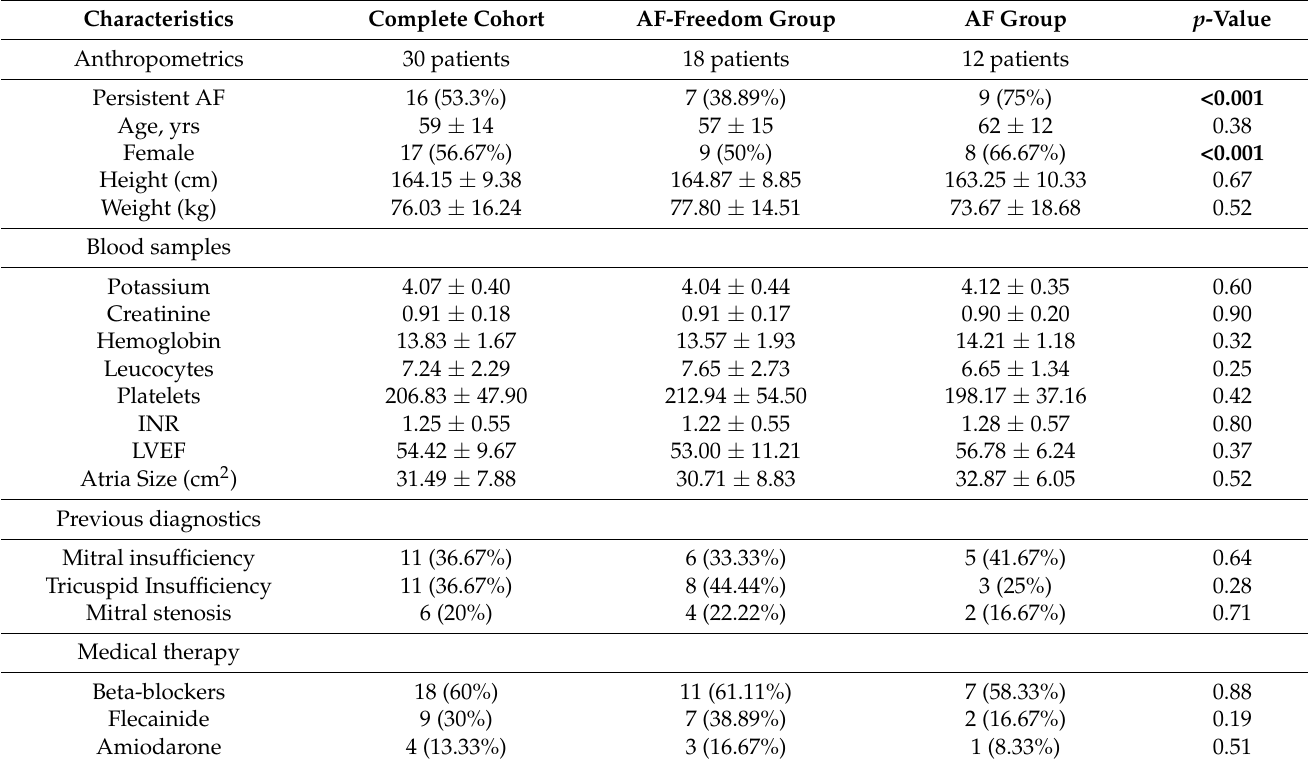
Table 1. Patients’ clinical characteristics and univariate analysis for 1-year outcome after ablation. Significant p -values can be found in